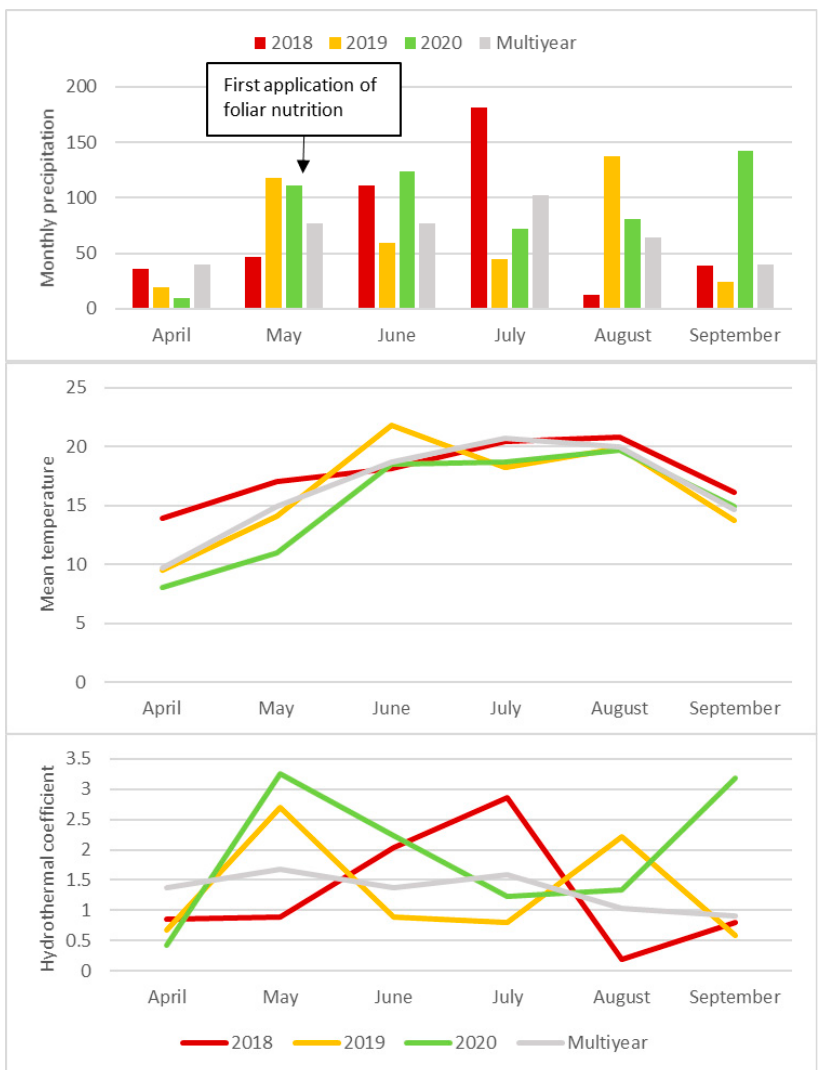
Figure 2. Weather conditions (monthly precipitations in mm, mean temperature in °C and hydro- thermal coefficient k) during the growing season of sugar beet (2018–2020). Multiyear